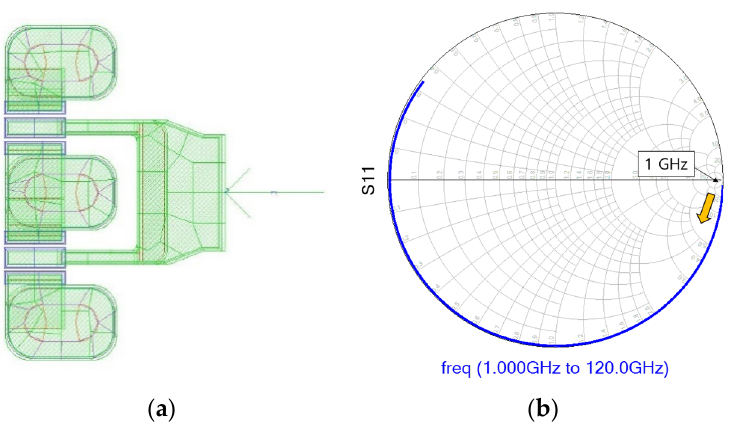
Figure 3. ( a ) EM layout and ( b ) simulation result of the simplified one-port drain-source via struc- ture.